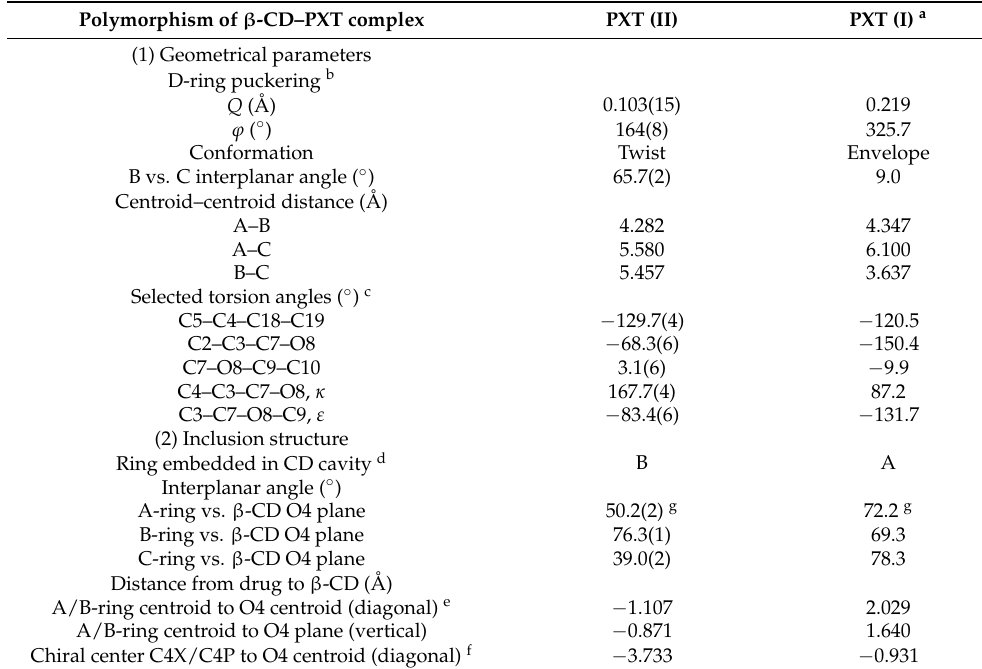
Table 1. Comparisons of geometrical parameters and inclusion structures of PXT in the 1:1 β -CD–PXT HCl (crystal form II) and the 2:1 β -CD–PXT base (crystal form I). Polymorphism of β -CD–PXT complex